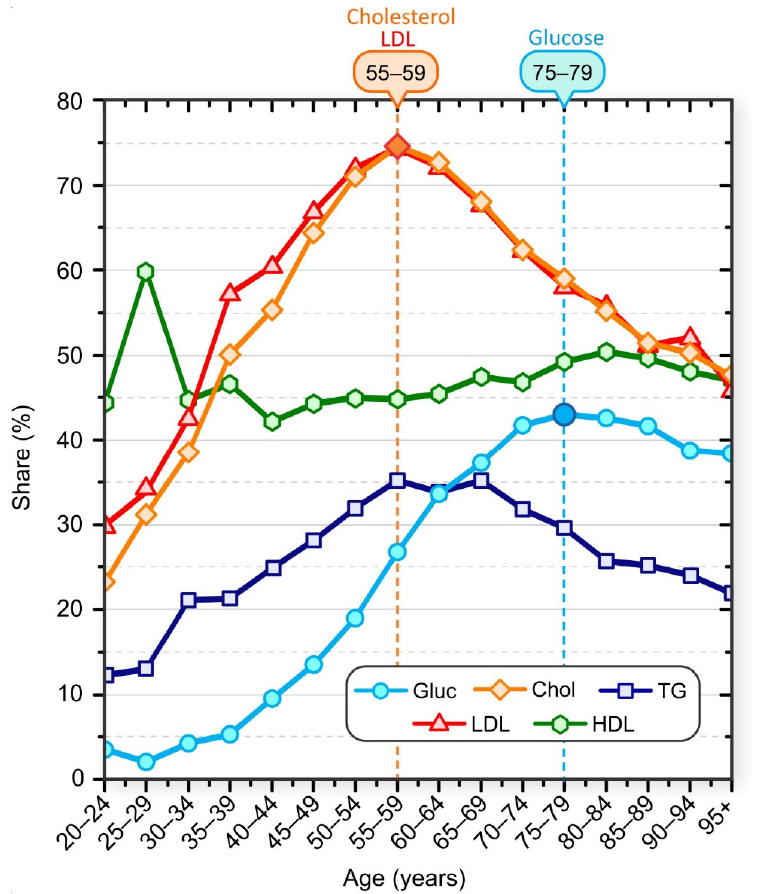
Figure 1. Share of patients with elevated laboratory test results: Cholesterol (orange diamonds), LDL (red triangles), glucose (blue circles), HDL (green hexagons), and TG (dark blue squares). Patients were aggregated into nonoverlapping 5-year age groups.